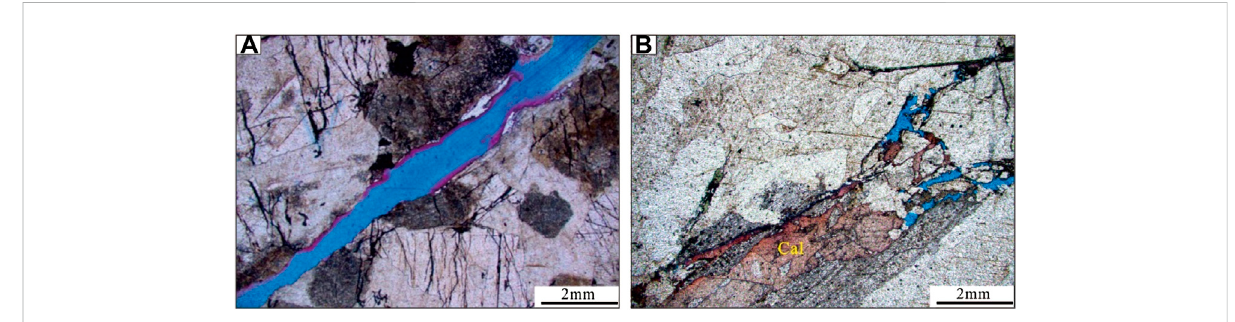
FIGURE 12 Dissolutionfracturesinthinsectionsofmetamorphicrocksinthestudyarea (A) Earlytectonicfracturesexhibitingcorrosionandexpansion,well BZ19-G, 4599 m; (B) The mineral of calcite in the fi lling fracture is partially dissolved, which makes the initial fracture effective, BZ13-G,4732 m).